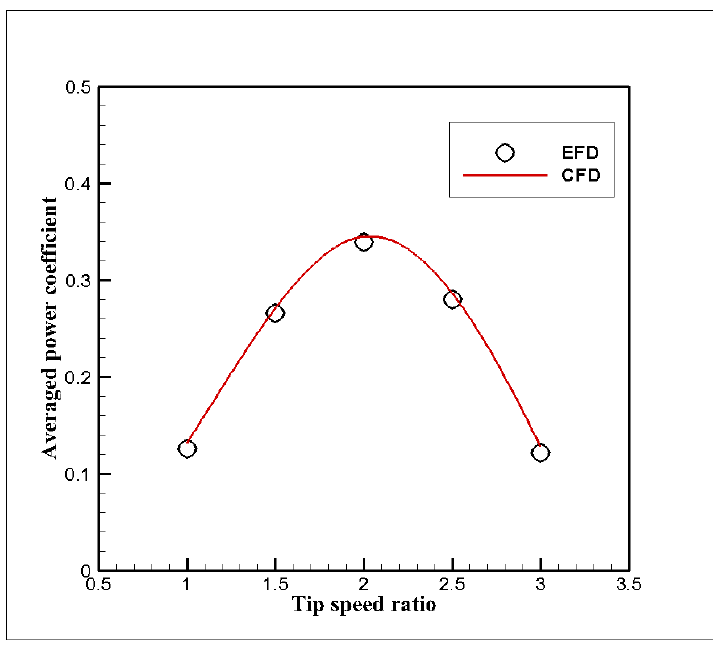
Figure 10. Averaged power coefficients of the Darrieus turbine at various TSRs.